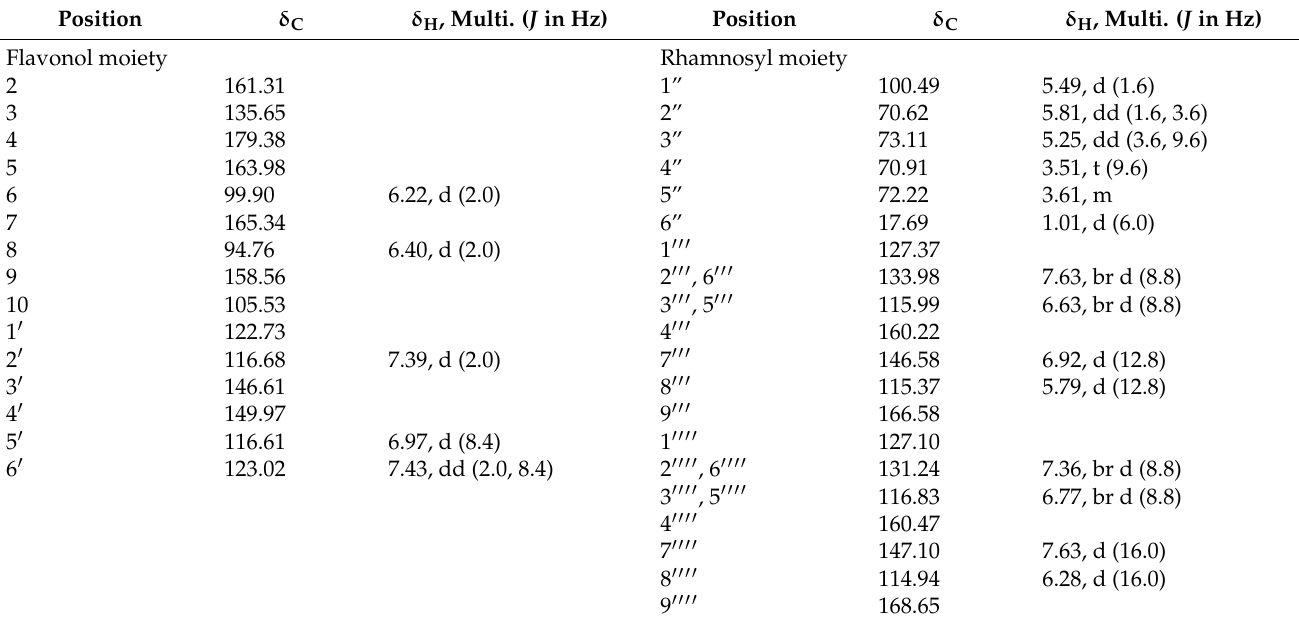
Table 2. NMR spectroscopic data (in CD 3 OD) for compound 2 .